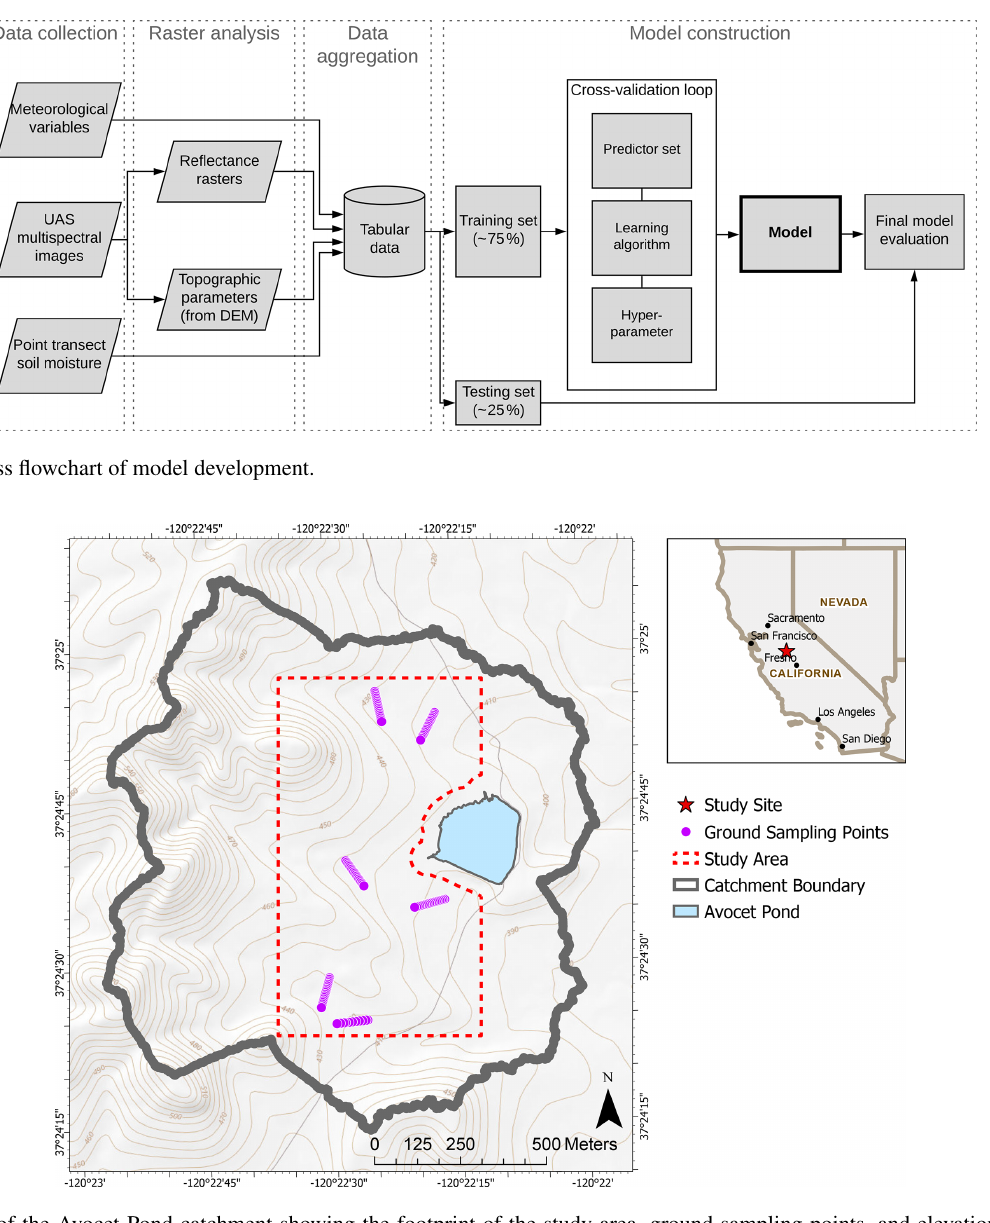
Figure 2. Map of the Avocet Pond catchment showing the footprint of the study area, ground sampling points, and elevation contours in meters. Inset shows the location of the study site in